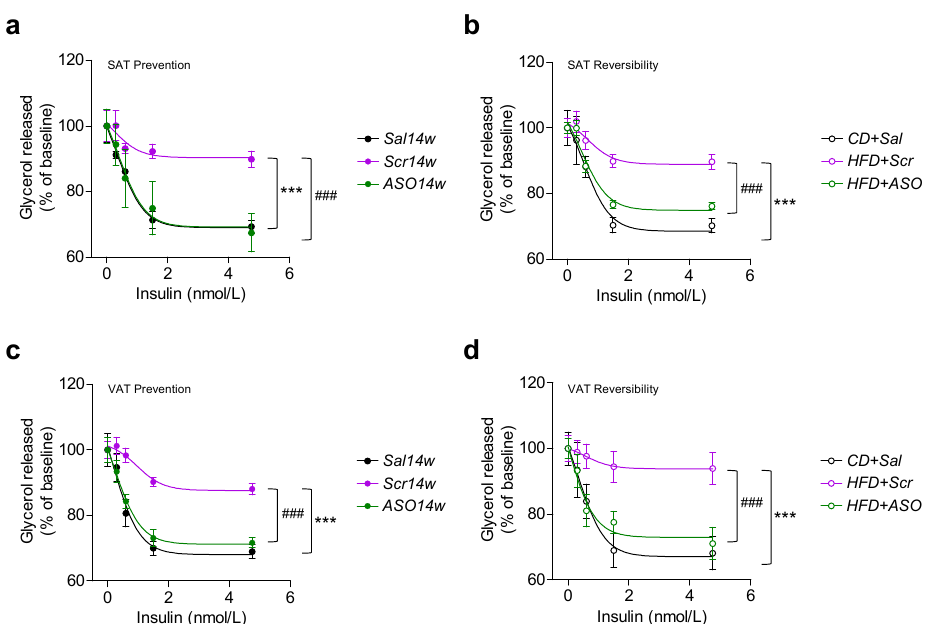
Figure 5. ApoCIII reduction improves WAT insulin sensitivity. ( a – d ) Concentration-dependent inhibition of isoproterenol-induced lipolysis by insulin in isolated adipocytes from ( a , b ) SAT from mice in ( a ) the prevention and ( b ) the reversibility studies and ( c , d ) VAT from mice in ( c ) the prevention and ( d ) the reversibility studies. Data are expressed as mean ± SEM of n = 5 individual mice per experimental group and controls. *** p < 0.001 for differences in the prevention study. ### p < 0.001 for differences in the reversibility study.